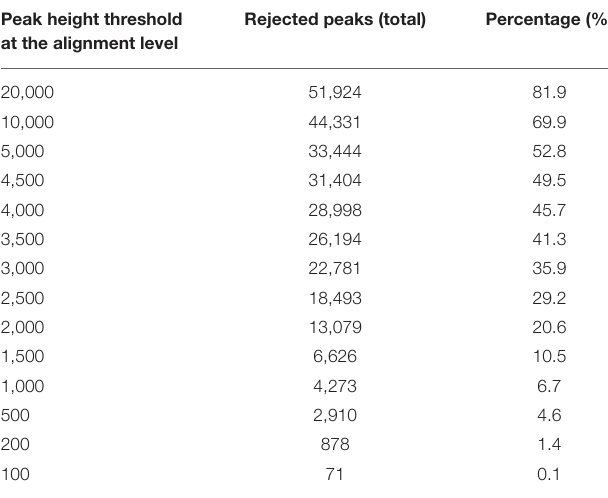
TABLE 4 | Effect of peak height thresholds on the peak rejection at the peak alignment